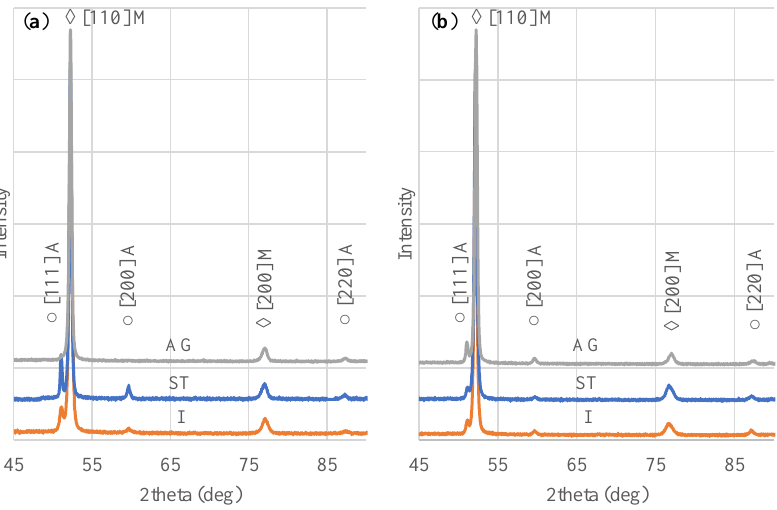
Figure 7. XRD patterns of the ( a ) LPBF and ( b ) wrought alloys. Table 5. Table of the measured percentage of RA from the XRD patterns.